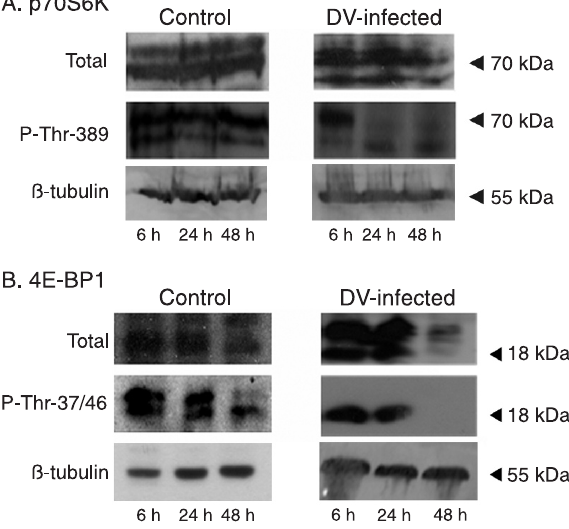
Figure 2. p70S6K and 4E-BP1 phosphorylation is modified by dengue virus (DV) infection. Whole cell protein extracts from HepG2 cells infected with DV, or mock-infected for 6, 24 or 48 h, were prepared and 30 µg protein was analyzed by Western blot. Panel A , Western blot analysis of total p70S6K and its phos- phorylated form (P-Thr-389) using specific antibodies. Panel B , Western blot analysis of total 4E-BP1 and its phosphorylated form (P-Thr-37/46). β-tubulin was used to determine protein in- tegrity in both panels. One representative result is shown of three independent experiments.